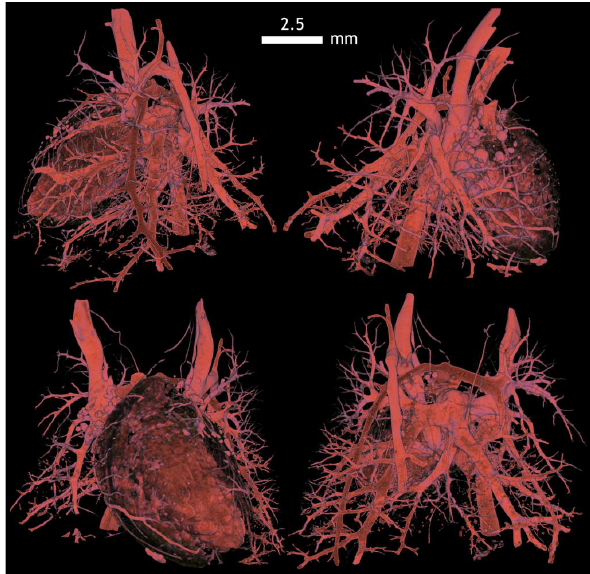
Figure A18. The corrosive specimen of the heart and blood vessels shows both the coronary arteries for the heart, the basic platform for incipient myocardial infarction, and the branching of the pulmonary artery and pulmonary artery diameters and their angles of spacing and segmentation. Here, is a physiological finding. The arrangement of the pulmonary arteries and their branching is disturbed in pulmonary embolism, vascular wall pathology and also in lung tumors.